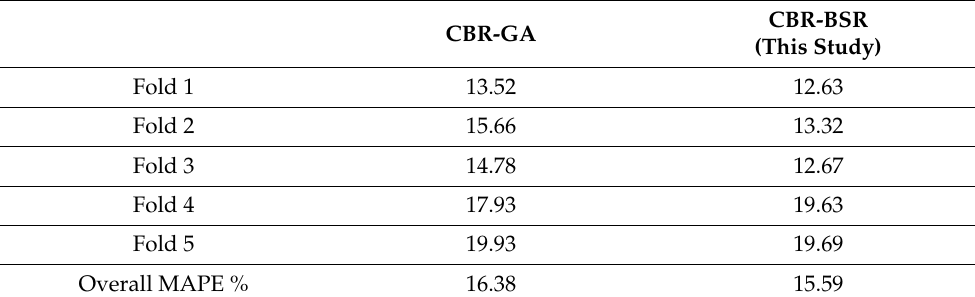
Table 4. Prediction Performances of Data set